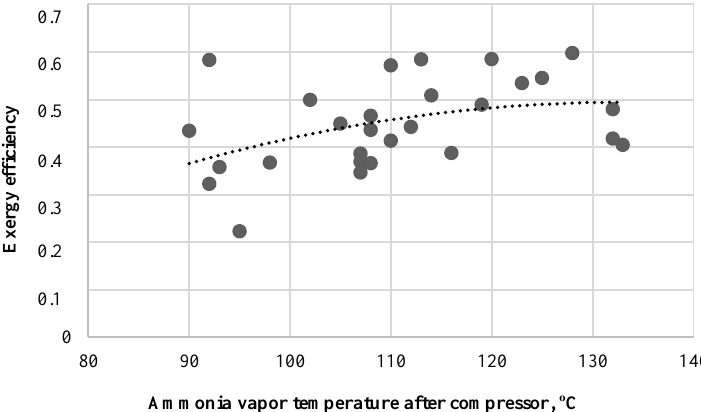
Fig. 2. Single-stage compressor refrigeration system exergy efficiency depending on ammonia vapor temperature after